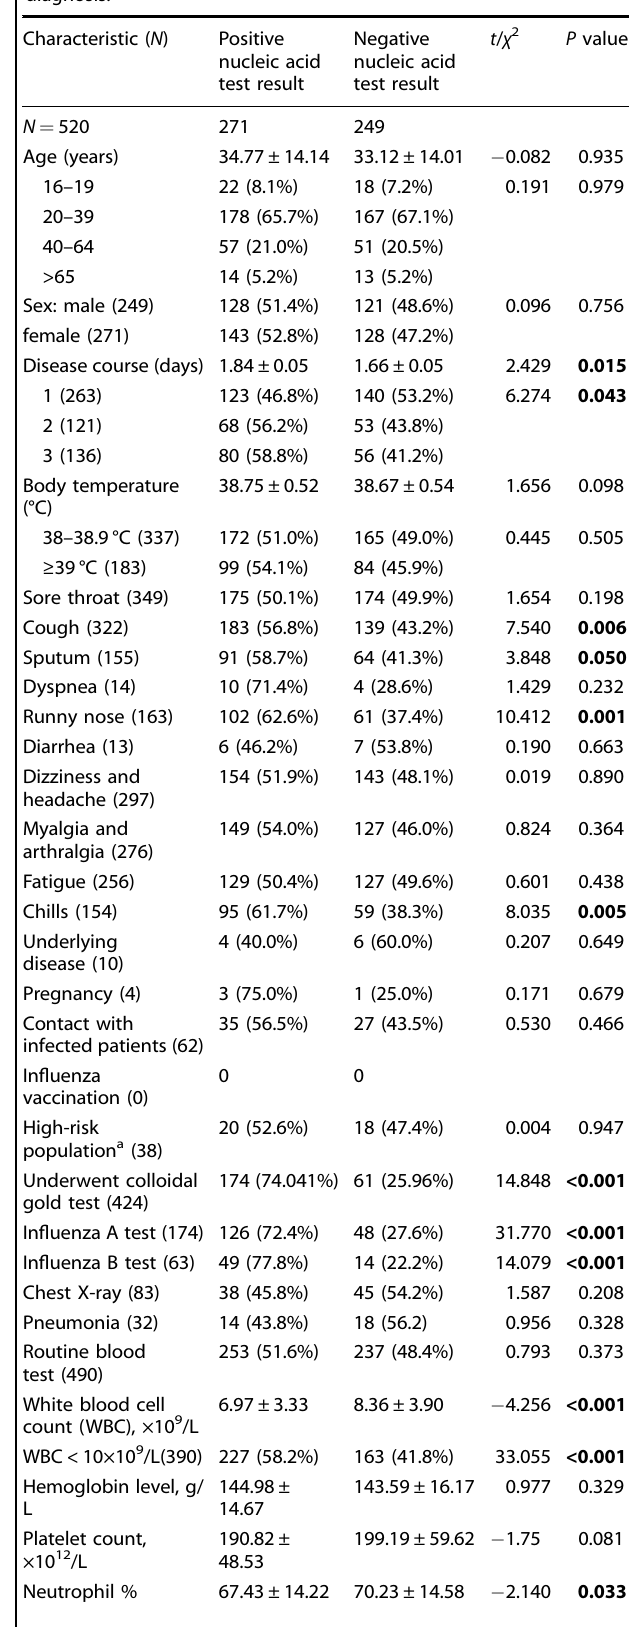
Table 2. Correlation between clinical characteristics and in fl uenza